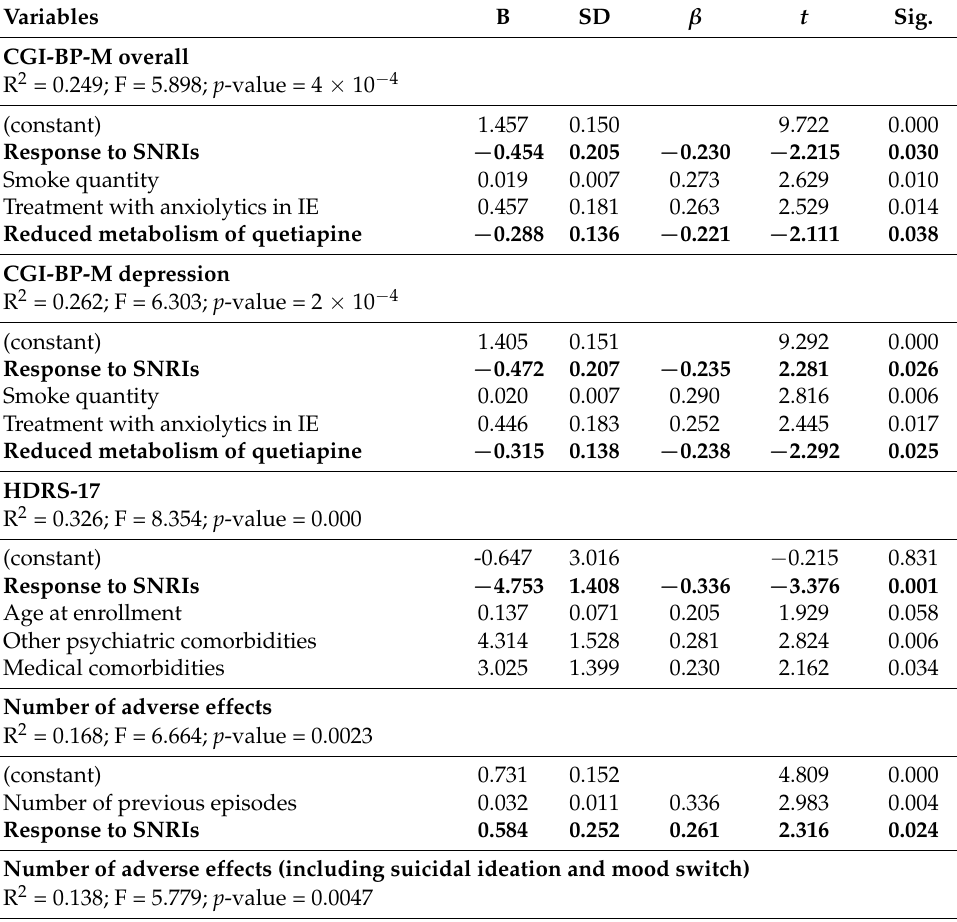
Table 3. Multiple linear regression results between continuous variables selected by the forward- selection method and the clinical outcome assessed with the CGI-BP-M (overall and depression subscale), the HDRS-17 and the number of adverse effects.